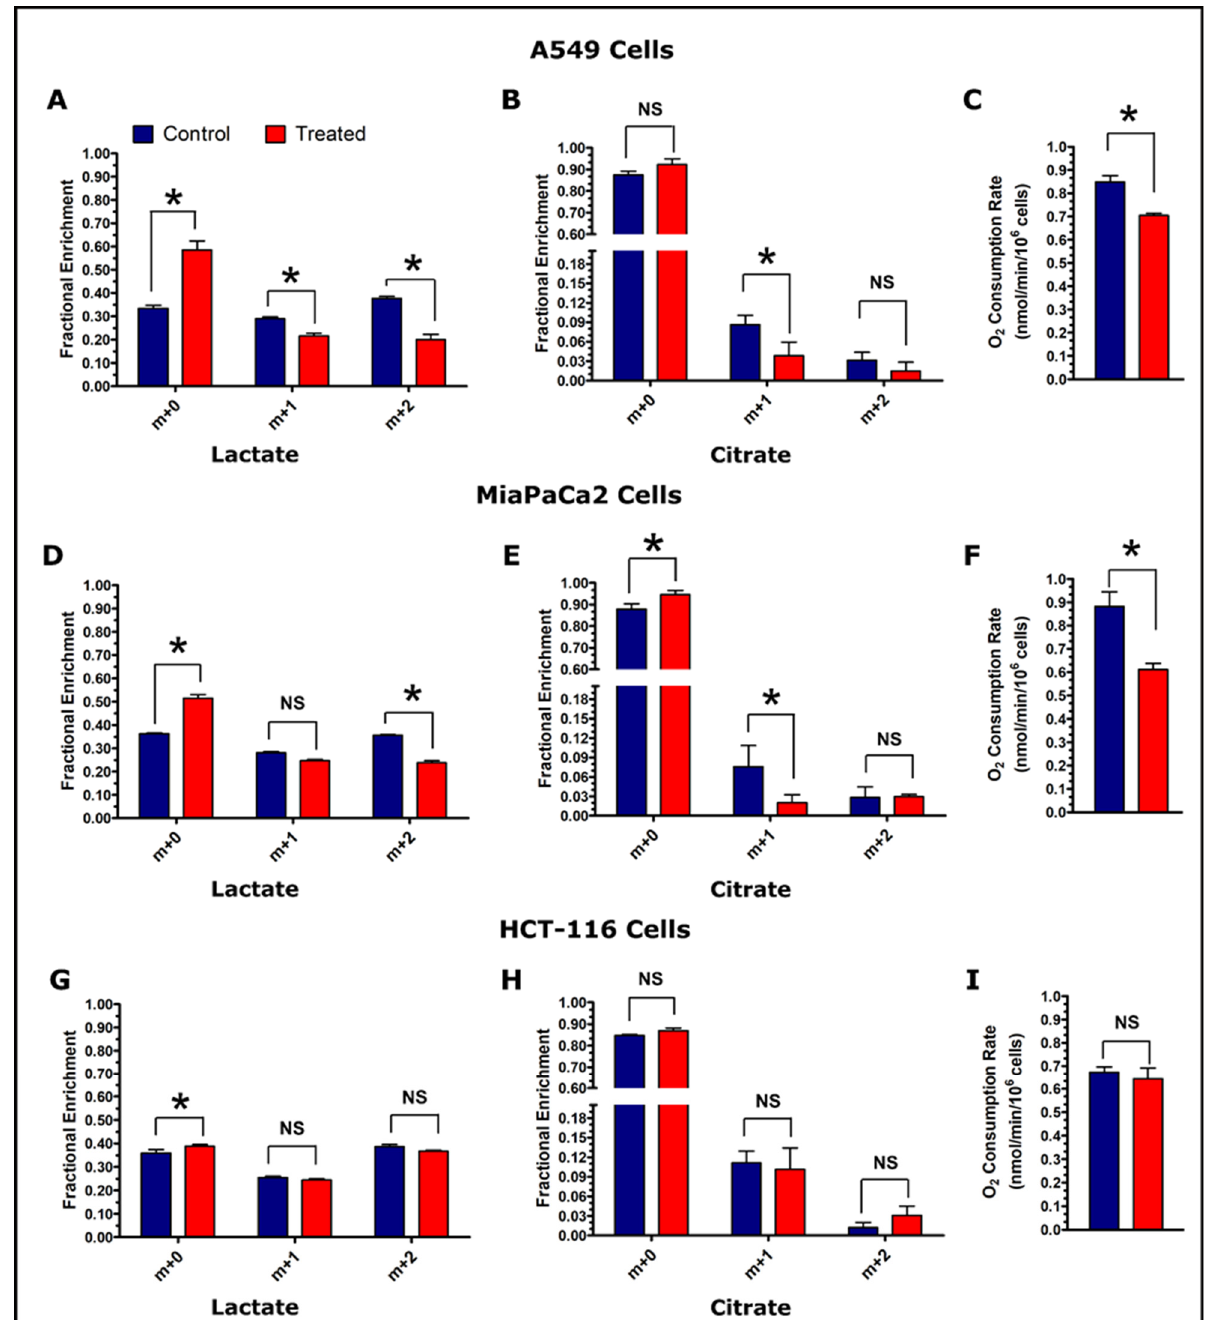
Figure 5. Assessment of glycolytic and TCA cycle activity in control and treated cells. Fractional enrichment of lactate and citrate, and O 2 consumption rate are shown for A549 cells (Panels, A – C ), MiaPaCa2 cells (Panels, D – F ), and HCT-116 cells (Panels, G – I ). Enrichment results were calculated from the GC-MS data of cell media samples collected at the 360 min post-treatment time point. The GC-MS data were corrected for natural isotope abundance using the Isotopomer Network Compartmental Analysis (INCA) software. (Note: N = 3: biological replicate data are represented as mean ± SEM. Significant levels were calculated using the Student’s t-test between control and treated groups and are displayed as: non-significant “NS” if p > 0.05 and “*” if p ≤ 0.05. Oxygen consumption was measured at the end of tracer experiment (total time period of 8 h) and O 2 consumption rates were calculated for the number of cells used for the measurements and normalized per million cells).